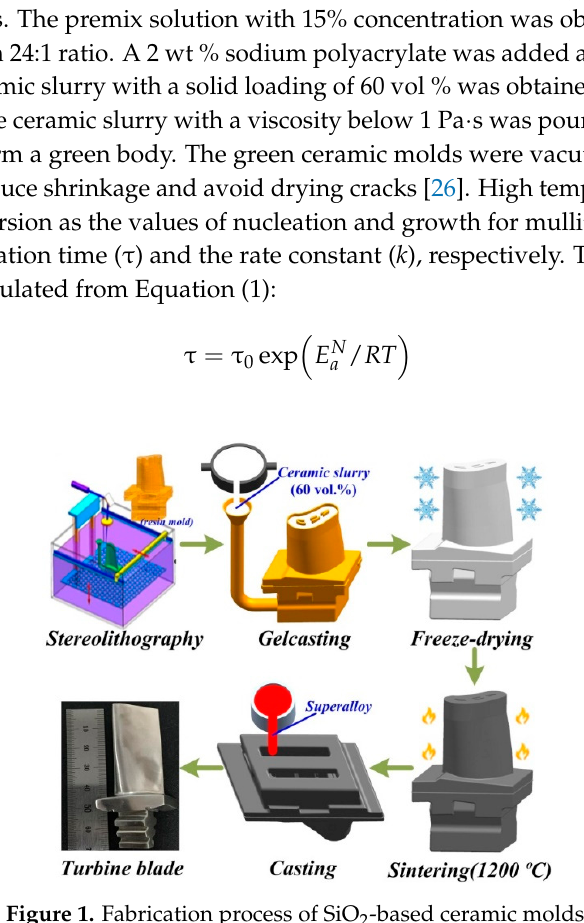
Figure 1. Fabrication process of SiO 2 -based ceramic molds.